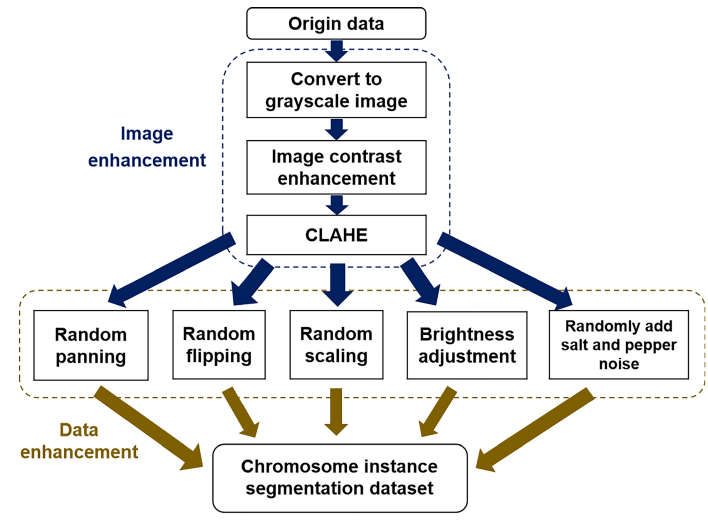
Figure 2. Schematic diagram of enhanced processing